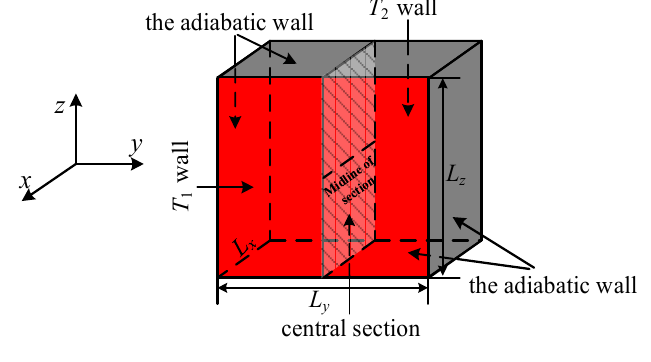
Fig. 1. Gas heat conduction